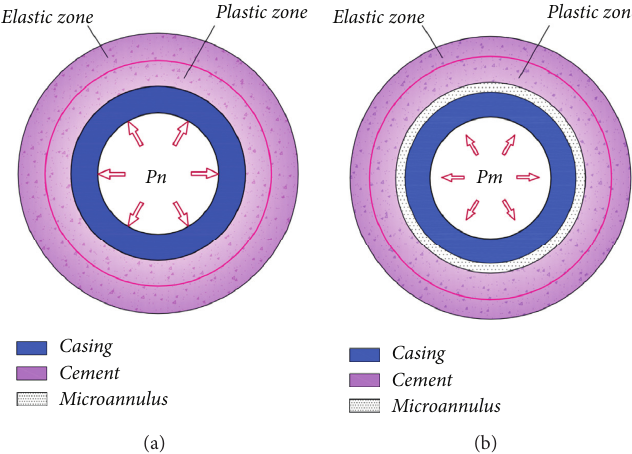
Figure 3: Formation of microannulus in casing-cement interface under inner pressure. (a) Injection. (b) After